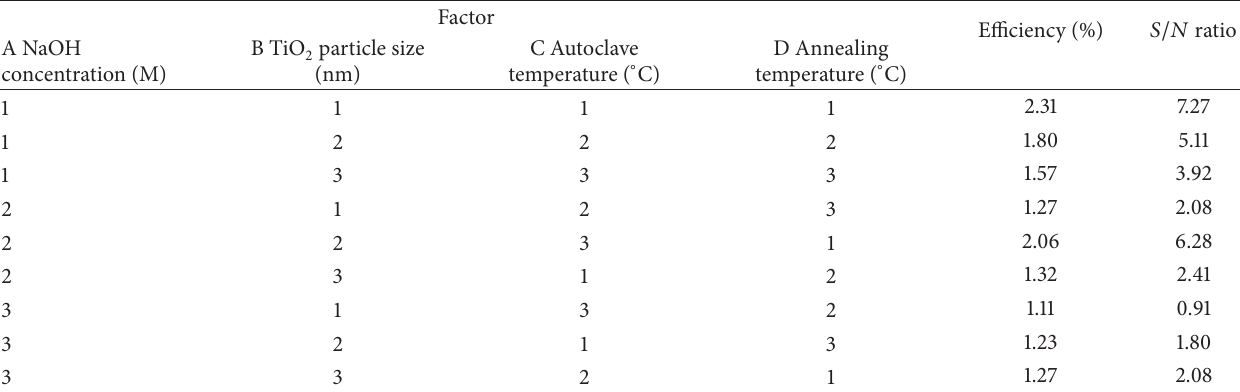
Table 3: The factor effects on the solar efficiency and 𝑆/𝑁